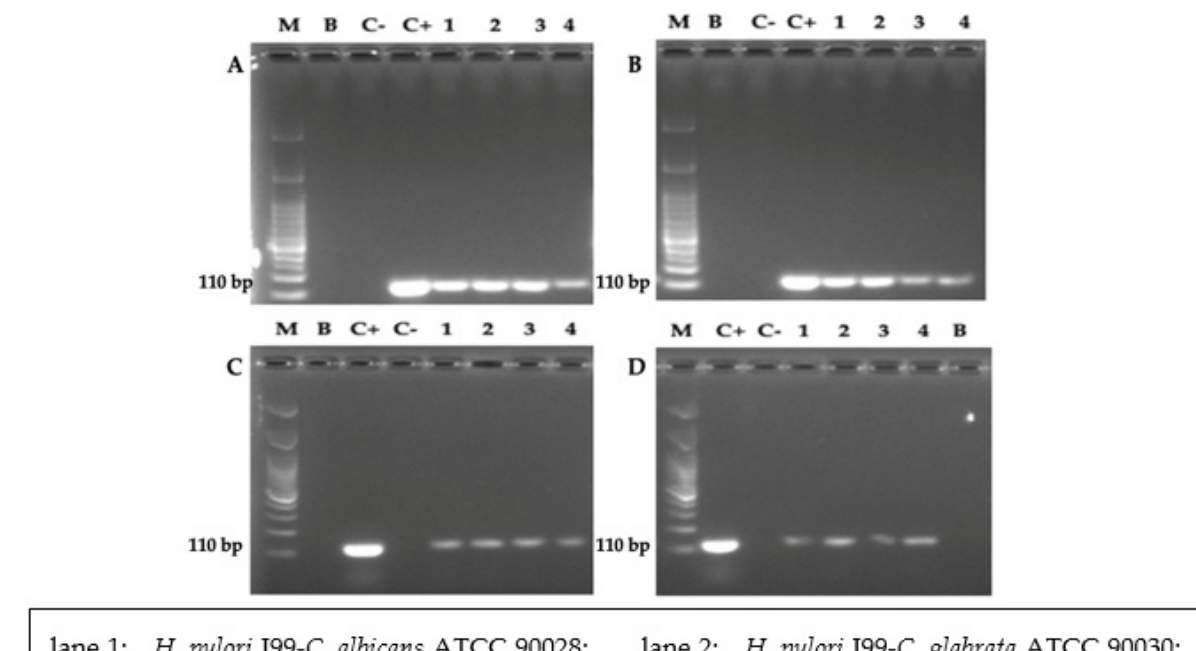
Figure 10. Image of a 2% agarose gel showing the amplicons obtained after amplifying the H. pylori 16S rRNA gene from total DNA extracted from Candida cells co-cultured with the different strains of H. pylori cultured in BB supplemented with 1%, 5% or 20% FBS or in SS. M: molecular weight markers, B: blank (master mix, primers, PCR grade water), C − : negative control (DNA from pure C. glabrata ATCC 90030), C+: positive control (DNA from pure H. pylori J99). Lanes 1–4 correspond to the amplicons obtained from DNA extracted from yeasts co-cultured with H. pylori . ( A ) Co-cultures in BB-1%FBS; ( B ) co-cultures in BB-5%FBS; ( C ) co-cultures in BB-20%FBS; ( D ) co-cultures in SS.